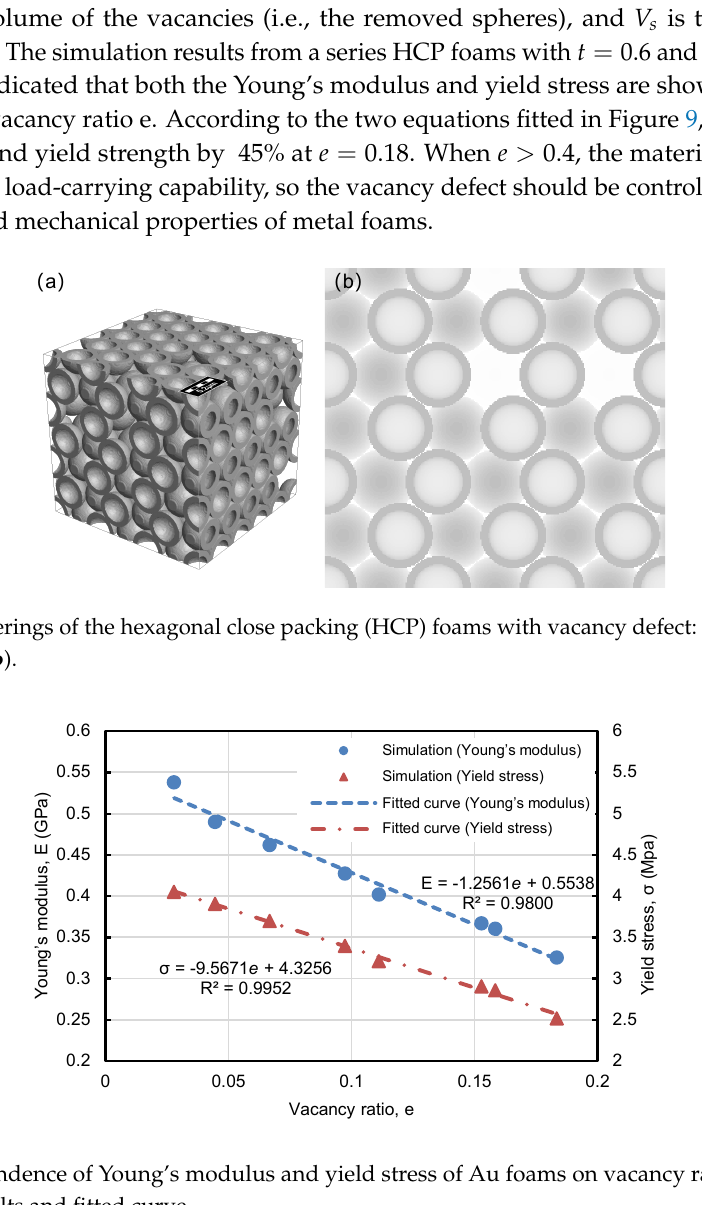
Figure 9. Dependence of Young’s modulus and yield stress of Au foams on vacancy ratio, including simulation results and fitted